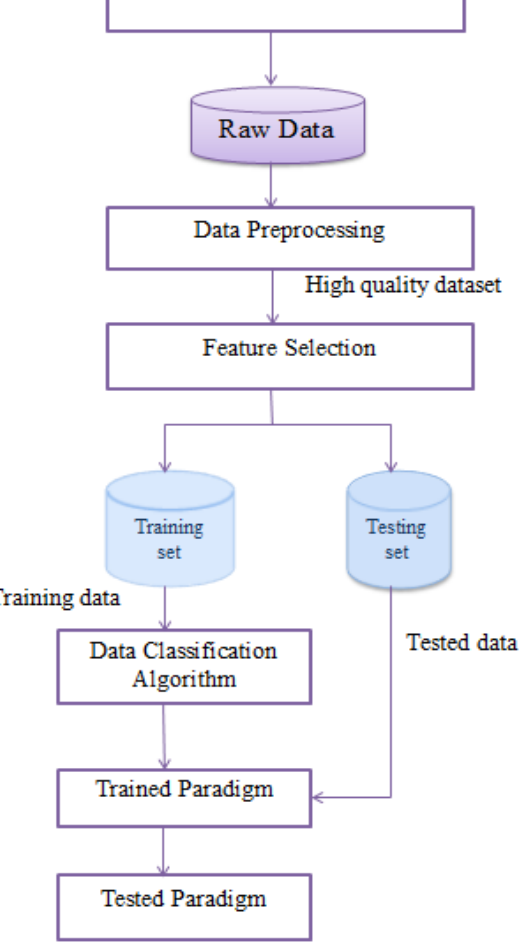
Figure 3. The proposed medical data classification model.